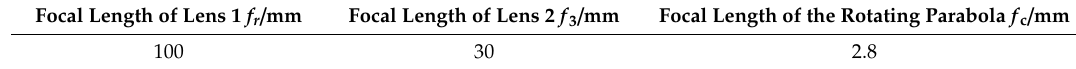
Table 1. System design